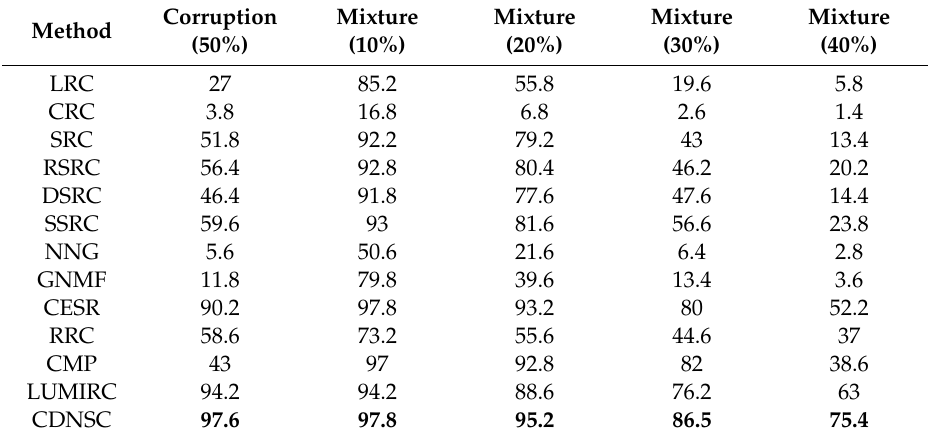
Figure 11. Query samples with dense corruption and the mixed-contaminations in the test set of the PolyU database. ( a ) The original sample, ( b ) Sample with 50% corruption, ( c )~( f ) Samples with 10%~40% mixed-contaminations.